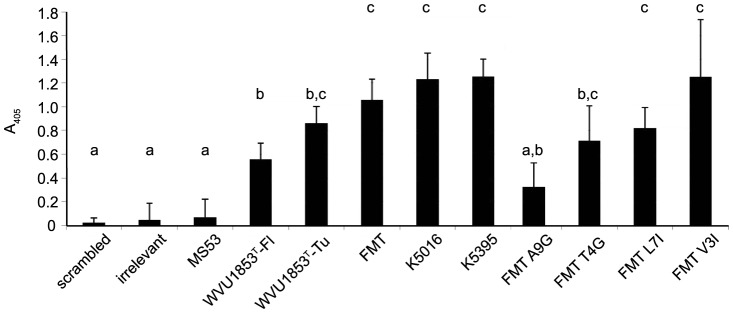
Erythrocyte membrane binding by PHM peptides.Bars depict mean ± standard error of the amount of synthetic peptide bound to avian erythrocyte membranes in an ELISA format (n = 3 independent replicates, with duplicate measurements of each peptide within replicate). The peptides represented variants of the putative hemagglutination motif (PHM) at the VlhA expression site of M. synoviae strains MS53, WVU1853T (Florida and Tunisian lineages), FMT, K5016 and K5395, which spanned a>20-fold range in quantitative hemagglutination phenotypes [14]. The positive control was the Tunisian lineage of strain WVU1853T, and negative controls were scrambled strain FMT peptide and an irrelevant peptide from a distant site in VlhA from the Florida lineage of strain WVU1853T. Different letters above the bar indicate means that differ (P<0.05 or less) by Tukey-Kramer Honestly Significant Difference test. As predicted, the directed substitution Ala9Gly significantly reduced binding versus the parent peptide from strain FMT, and Thr4Gly tended to reduce binding, whereas Val3Ile and Leu7Ile did not significantly alter binding.